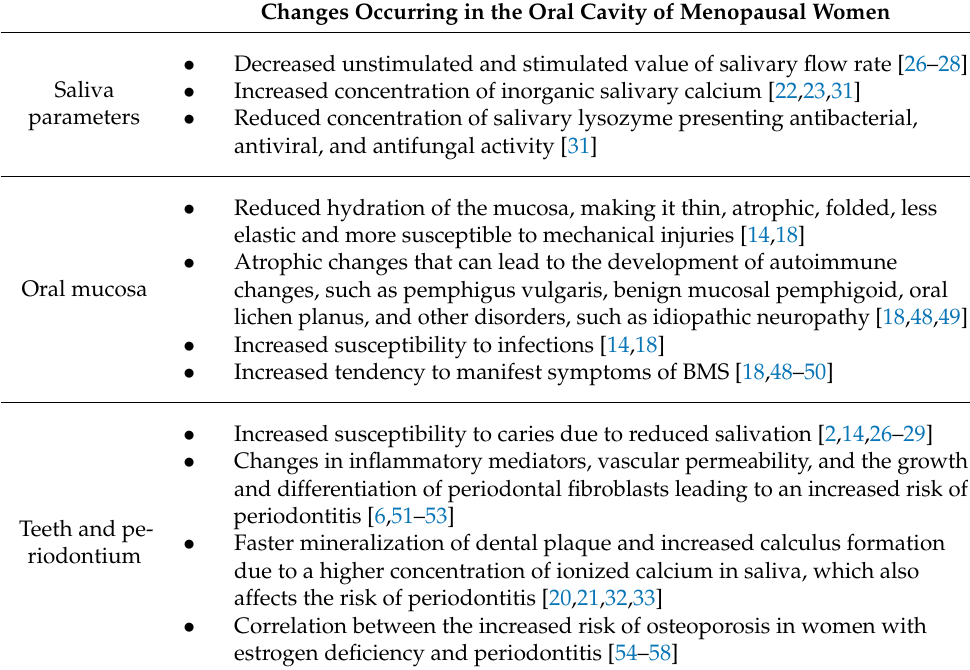
Table 1. Changes in the oral cavity of menopausal women in terms of parameters of saliva, mucosa, teeth and periodontium.